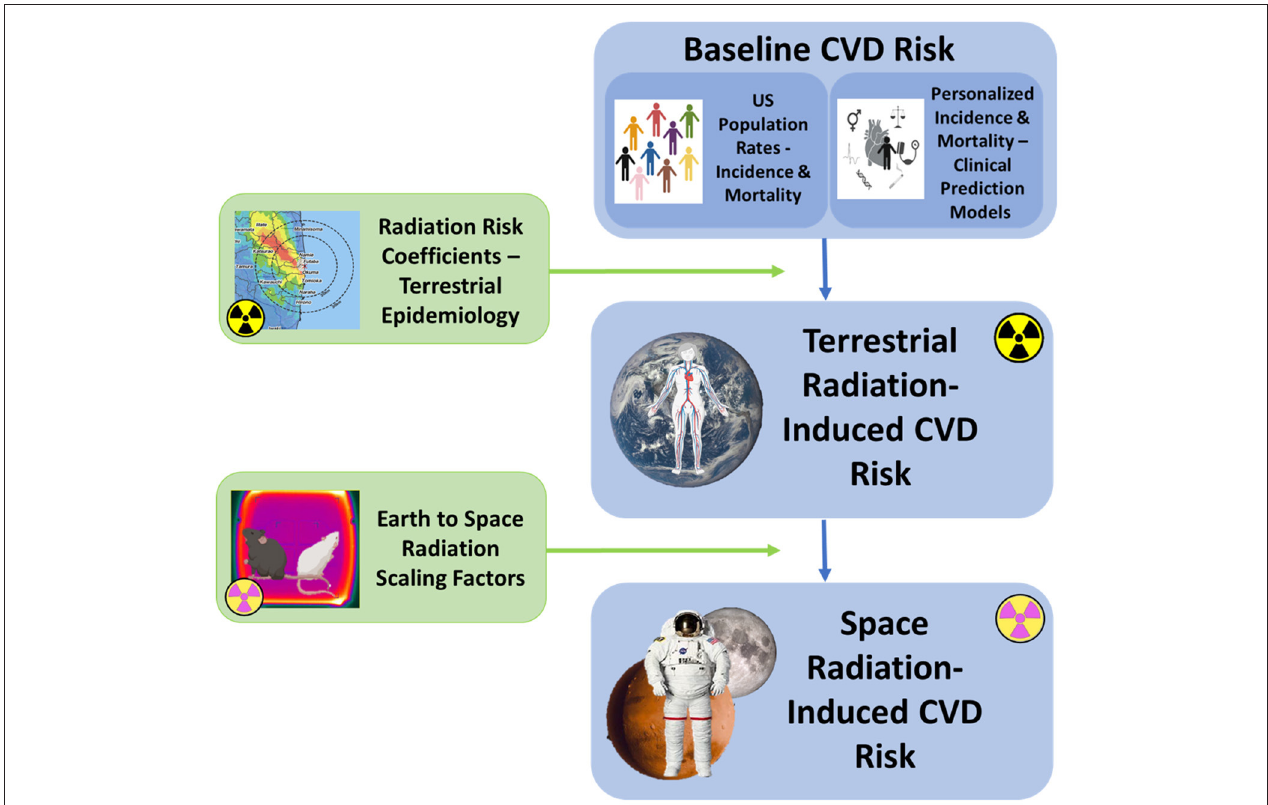
FIGURE 3 | Schematic overview of the major components of the NASA REID model proposed for space radiation CVD risk estimation. Risk calculations contain three components, the same as described for the NASA Space Cancer Risk model (14). The first component involves identification of the baseline CVD incidence and mortality rates, derived either from the United States population or from an integrated clinical prediction model (CPM) for individualized risk estimation. The second component calculates the excess RICVD risk from Earth-based exposures. The third component performs the calculations required to extrapolate this risk to the spaceflight environment using radiation scaling factors that account for the potentially more biologically damaging nature of space radiation. Scaling factors for CVD endpoints are currently under investigation (